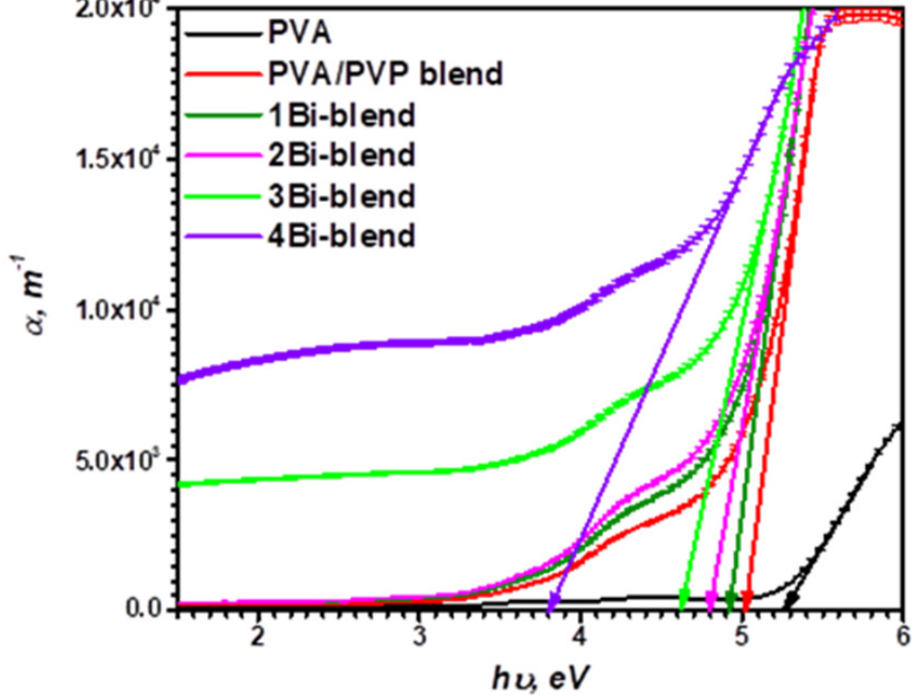
Figure 6. Variation of the coefficient of optical absorption ( α ) via the photon energy ( h ν ) of pristine